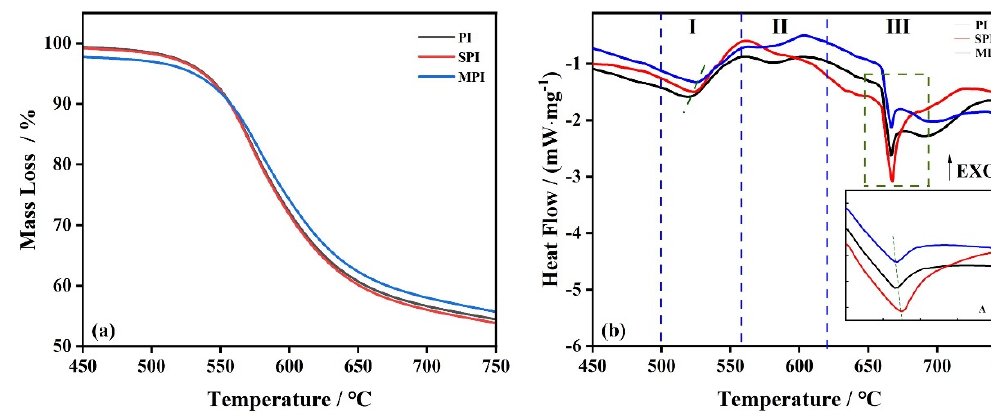
Figure 4. TG ( a ) and DSC ( b ) curves of three substances under an N 2